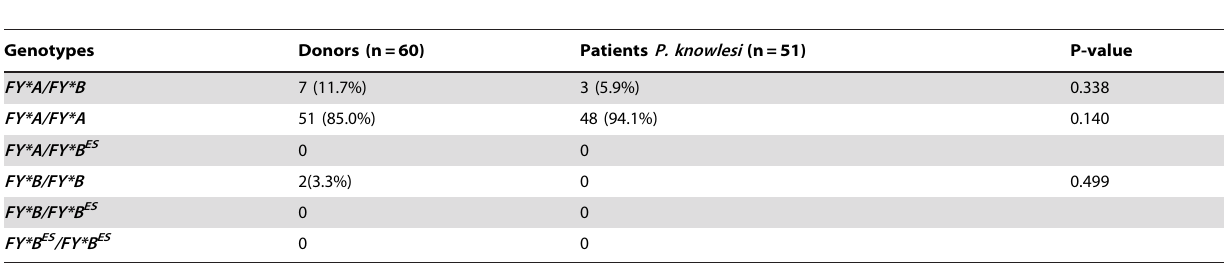
Table 2. Comparison of genotypic frequencies between blood donors and P. knowlesi infected